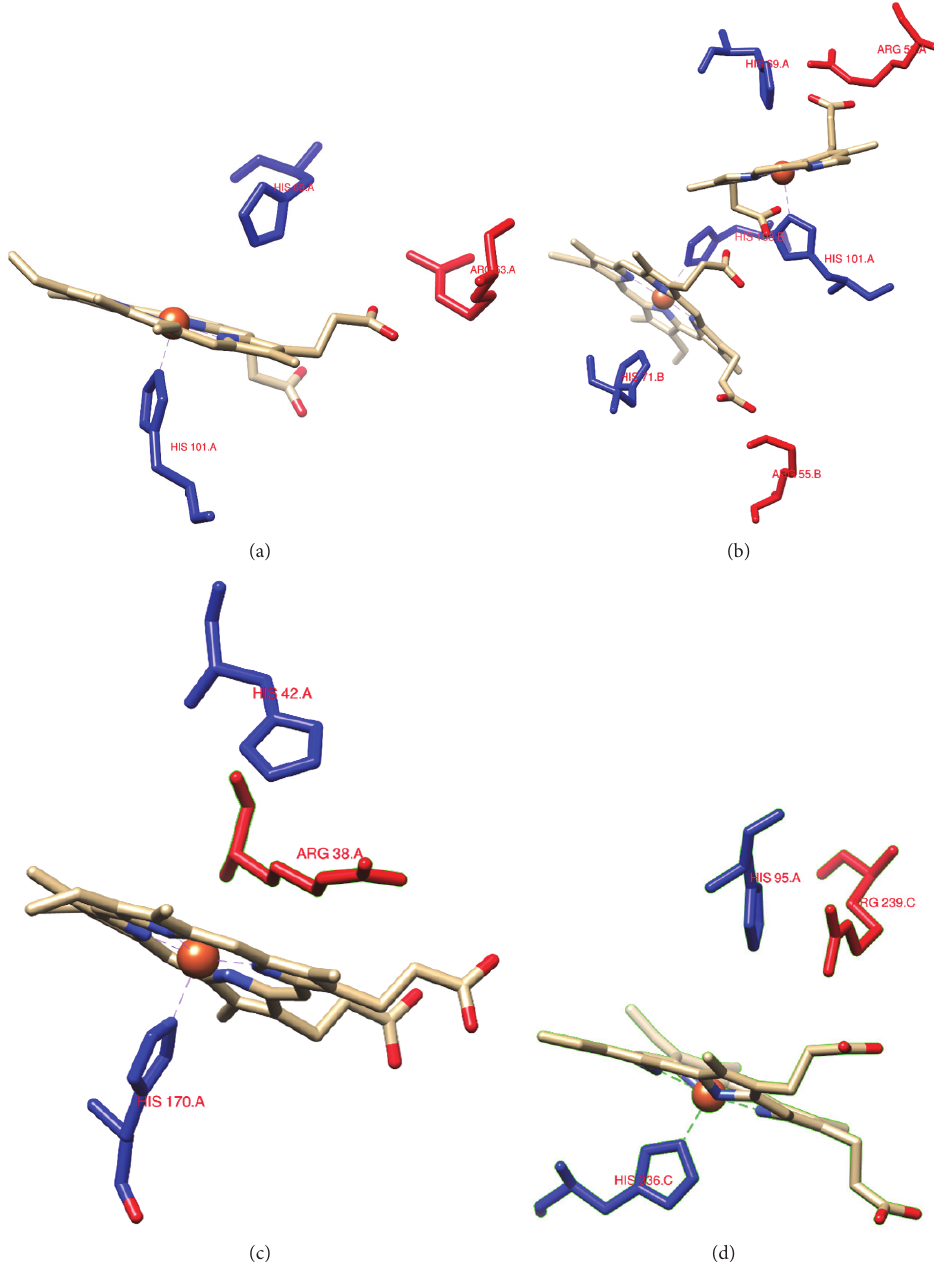
Figure 7: The heme and near key residues of Si-Hb I (a), Si-Hb II (b), HRP (c), and MPO